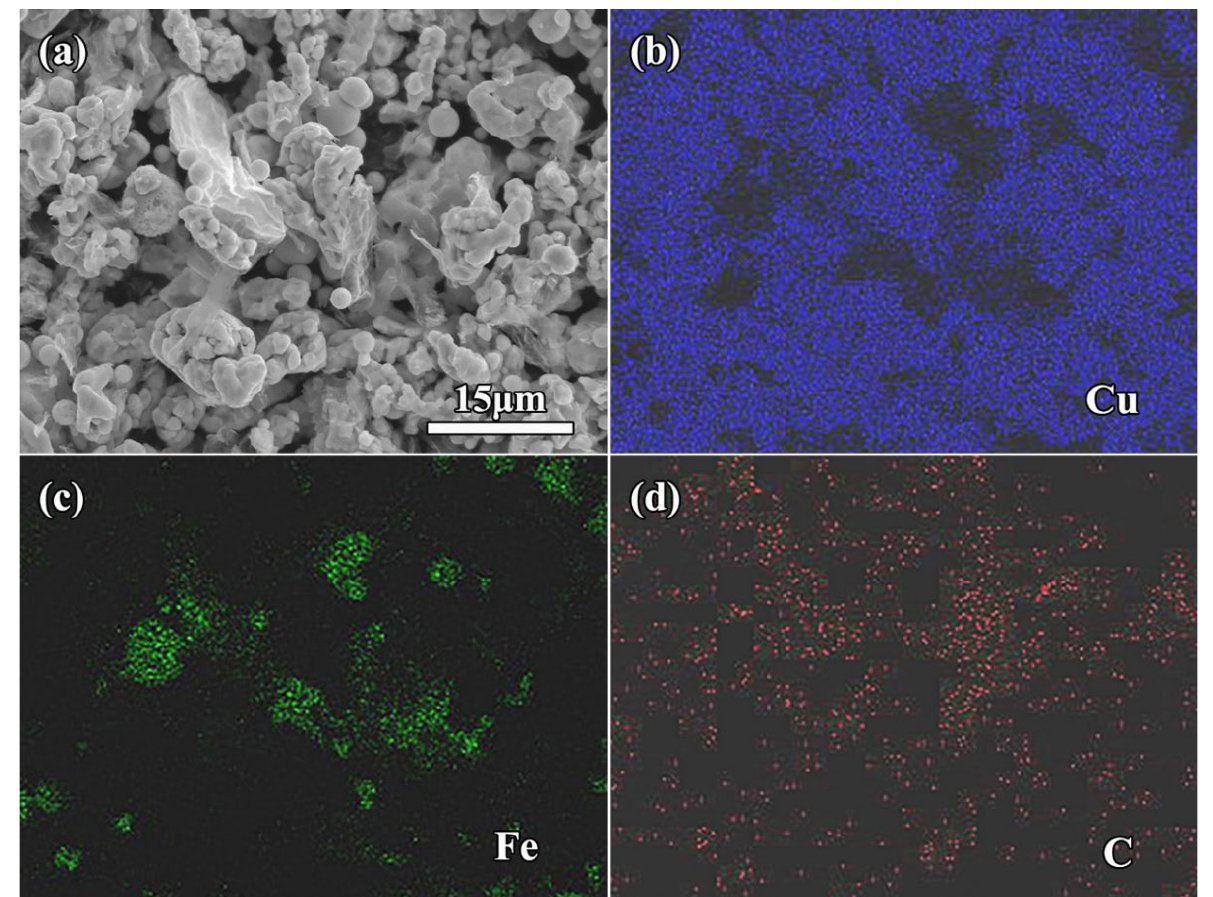
Figure 4. High-magnification SEM micrographs showing the rGO nanosheets coated on the surface of Fe microspheres ( a ) and Cu particles ( b ) in the mixture powders.